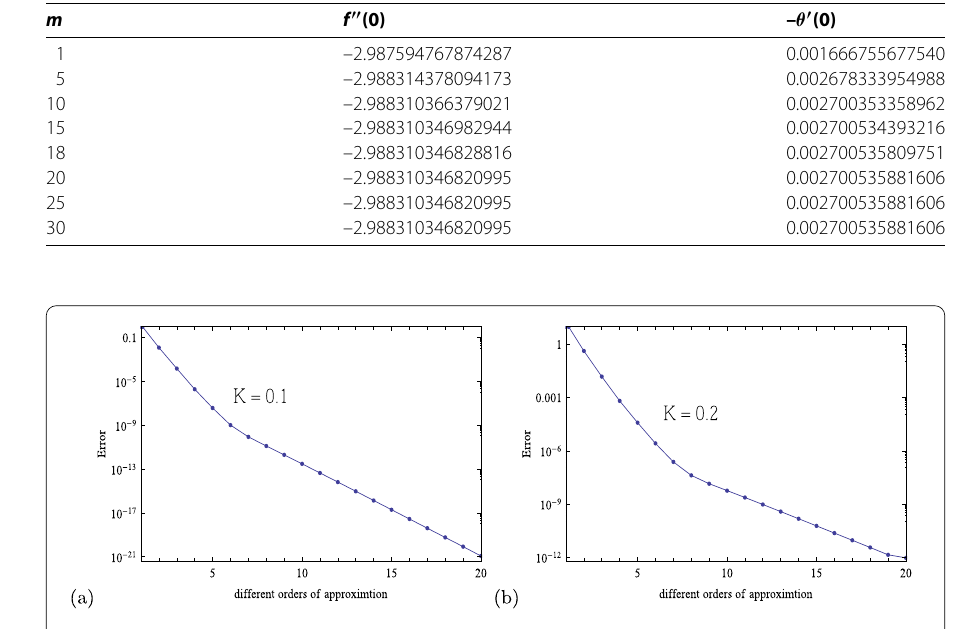
Figure 1 Ma = 1, M = 1, ϒ = 0.127013, Pr = 0.2, S = 0.2 and Gr =